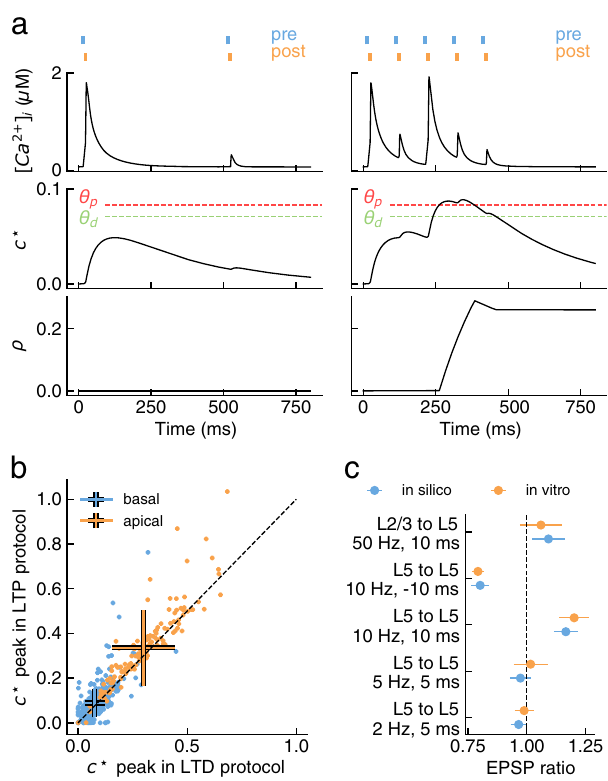
Fig. 2 Plasticity model components and parameter optimization. a Evolution of plasticity model state variables during coincident activation of pre- and postsynaptic neurons at 2 Hz (left) and at 10 Hz (right). The instantaneous calcium concentration ( c ; top) is integrated overtime to produce a suitable readout ( c ⋆ ; middle) for plastic changes, expressed as an increase of synaptic ef fi cacy ( ρ ; bottom). Crossing the depression threshold ( θ d ; green) causes a decrease in the synaptic ef fi cacy whereas crossing the potentiation threshold ( θ p ; red) results in an increase. b Comparison of calcium integrator peaks during LTD-inducing protocol (10 Hz, − 10 ms) against LTP-inducing protocol (10 Hz, + 10 ms). Peaks are well clustered by dendritic location (apical, orange; basal, blue) and on average slightly larger during the LTP protocol then during the LTD protocol. Error bars represent standard deviation and intersect at the mean value of the cluster. Peaks were estimated from a single repetition of the stimulation protocol at each synapse. c Comparison of mean EPSP ratio between model (in silico, blue) and experimental constraints (in vitro, orange) after model parameter optimization. Experimental data (in vitro) from Markram et al. 12 , Sjöström and Häusser 36 (see Table 1). Data reported as mean ± SEM. Welch's unequal variances two-sided t-test was n.s. for every protocol ( p-value from top to bottom: 0.78, 0.84, 0.67, 0.63, 0.69; n =